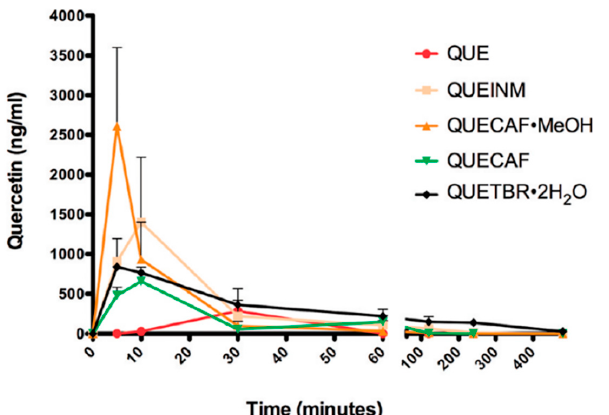
Figure 7. Pharmacokinetic profiles of QUE preparations (mean plasma concentration + SD, n = 3). Statistical significances were achieved between QUE-INM and QUE at t = 10 min ( p < 0.01) and between QUE-CAF·MeOH and QUE at t = 5 min ( p < 0.001), respectively. Adapted from [52] with permission. Copyright © 2011 American Chemical Society.